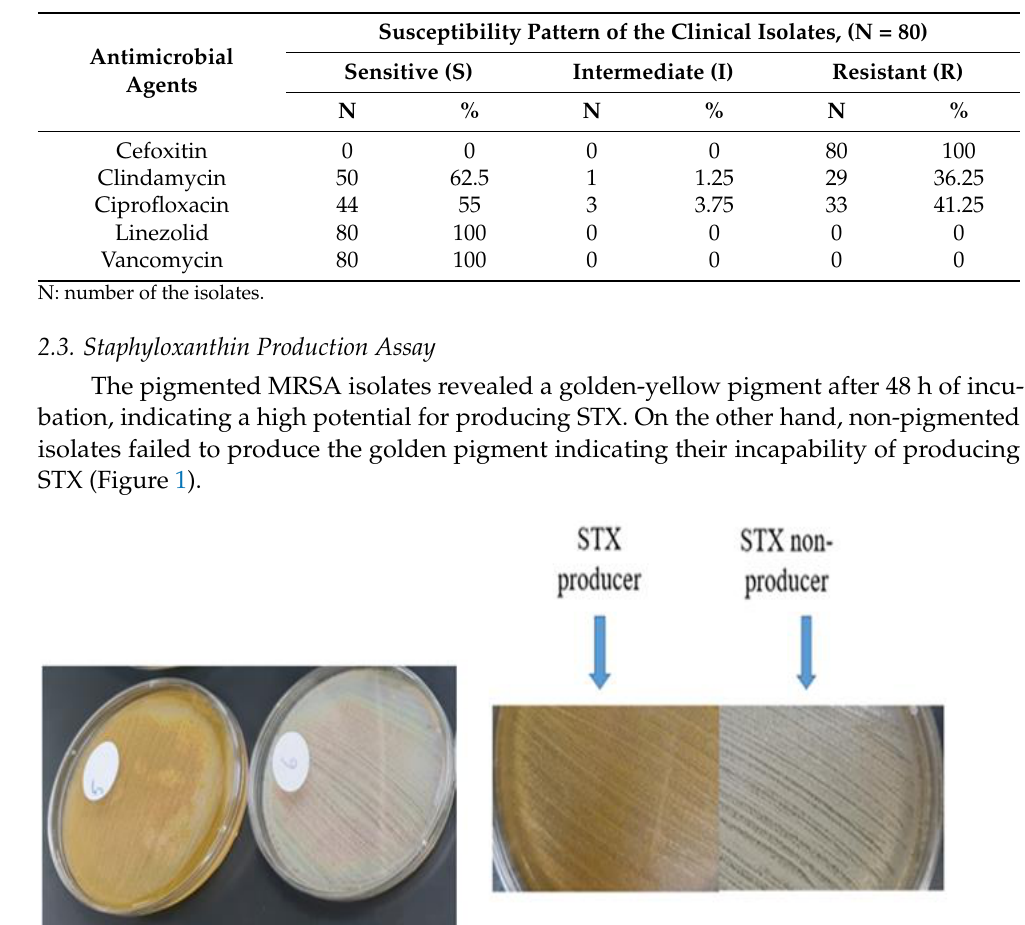
Table 1. Antimicrobial resistance pattern among clinical isolates.